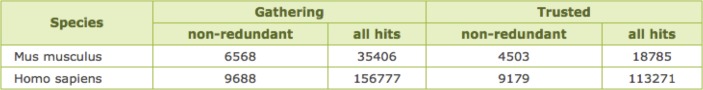
Hit statistics for MLT1A (DF0001126).